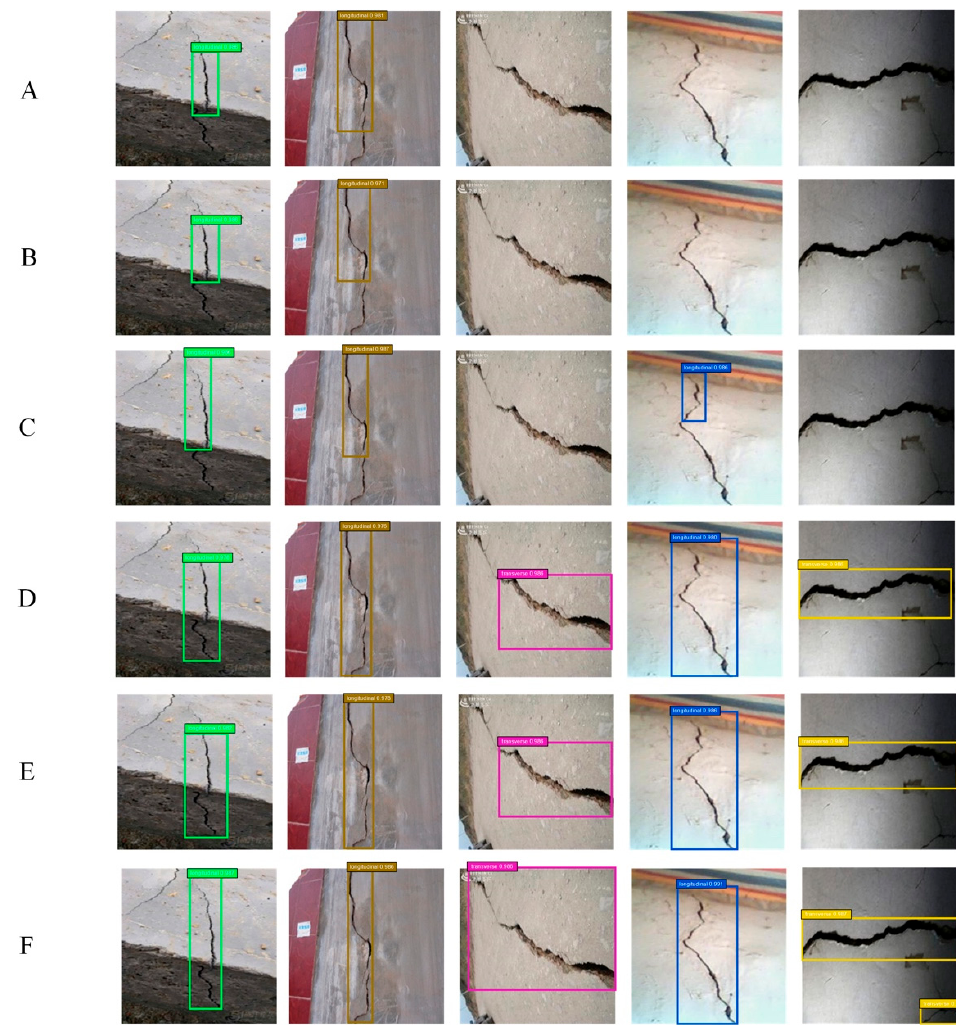
Figure 15. Comparison of the performance of the six detectors on five new images. A – C were detected by Faster R-CNN, R-FCN, and FPN-based Faster R-CNN without deformable modules, respectively; D – F were detected by Faster R-CNN, R-FCN, and FPN-based Faster R-CNN with deformable modules, respectively.